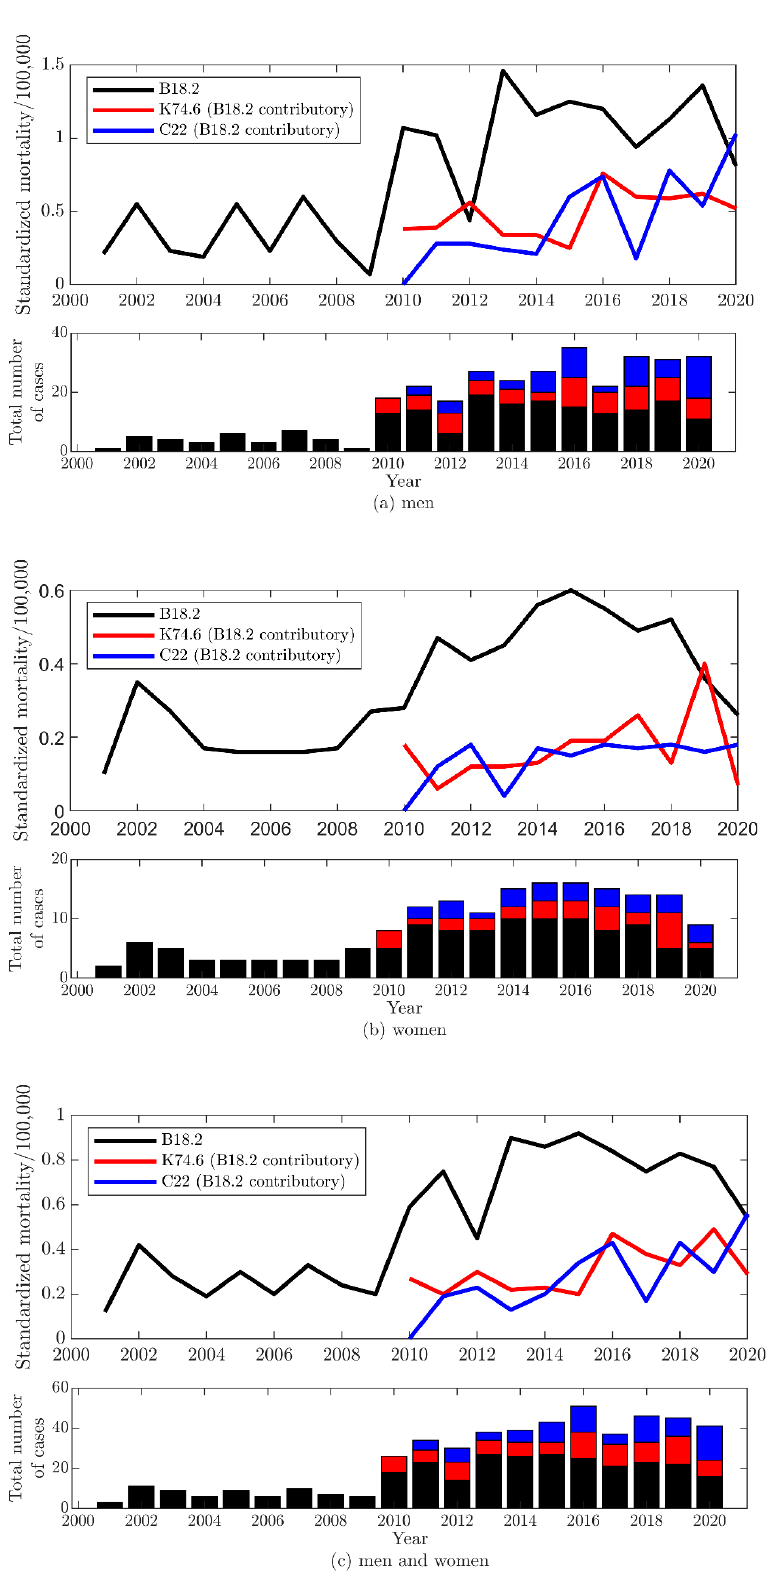
Figure 1. Sex-stratified and total annual age-standardized mortality rates per 100,000 people for chronic viral hepatitis C (CHC) as an underlying cause, unspecified liver cirrhosis and hepatocellular carcinoma with CHC as a contributory cause: ( a ) men; ( b ) women; ( c ) men and women.